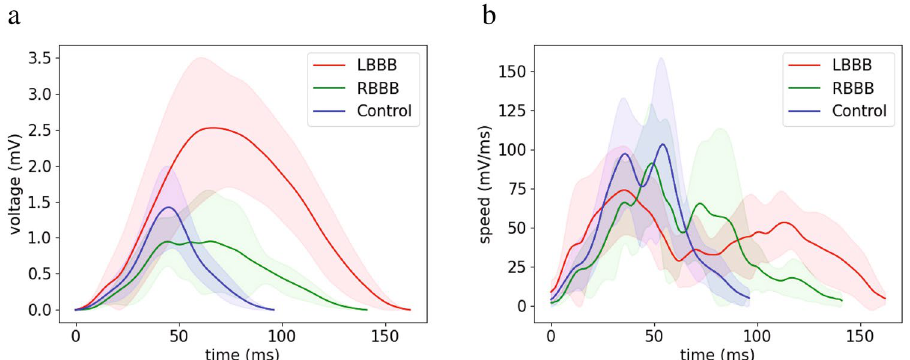
Figure 1. Population-wise kinetics of voltage and speed signals for left and right bundle branch block (LBBB and RBBB) compared with control patients. Signal lengths were normalized to the mean length to obtain the average signal for each condition. Shaded areas represent the standard deviation. ( a ) Voltage over time signals for control subjects (blue, n = 49), patients with right bundle branch block (RBBB, green, n = 9) or left bundle branch block (LBBB, red, n = 8) obtained from the PTB database. LBBB signals show higher voltage values and signal duration as compared with controls or RBBB. ( b ) Vector speed over time for the same three conditions. LBBB and RBBB signals show slower movement through the vector field as compared with controls. The figure was created using Python’s Matplotlib library (v.3.4.2.) 37